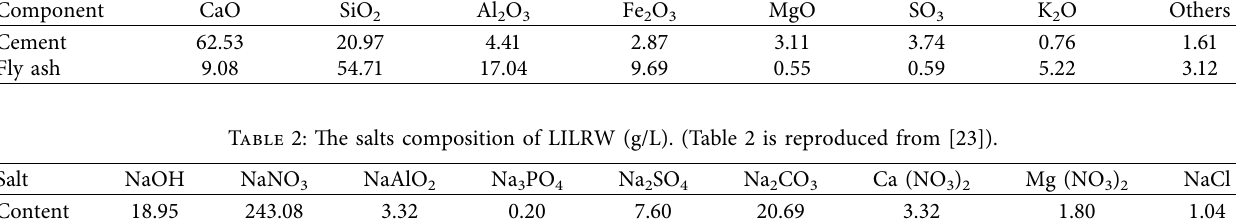
Table 1: The oxides composition of raw powder materials (wt. %). (Table 1 is reproduced from [23]). Component